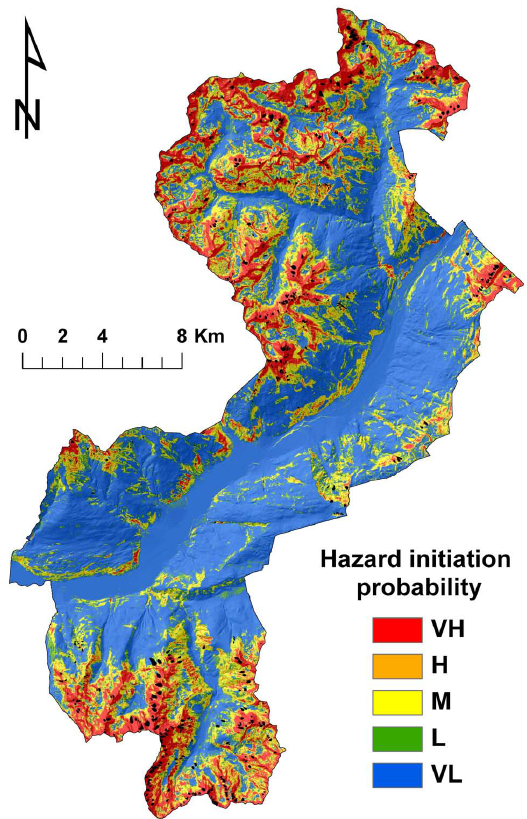
Fig. 5. Debris flow hazard initiation map classified in five classes. VL: very low; L: low; M: medium; H: high; VH: very high. Black dots are the debris flow scarps derived from the DF2001